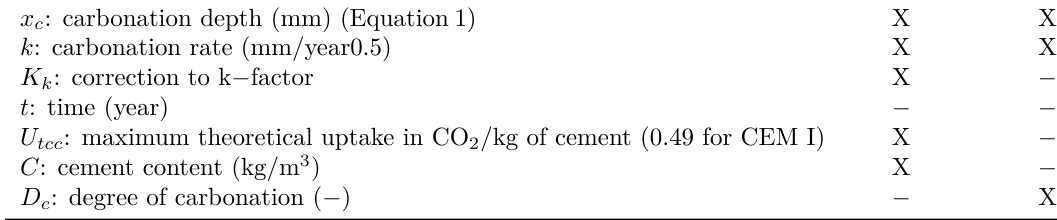
Table 2. Parameter of the NF EN 16757 model.